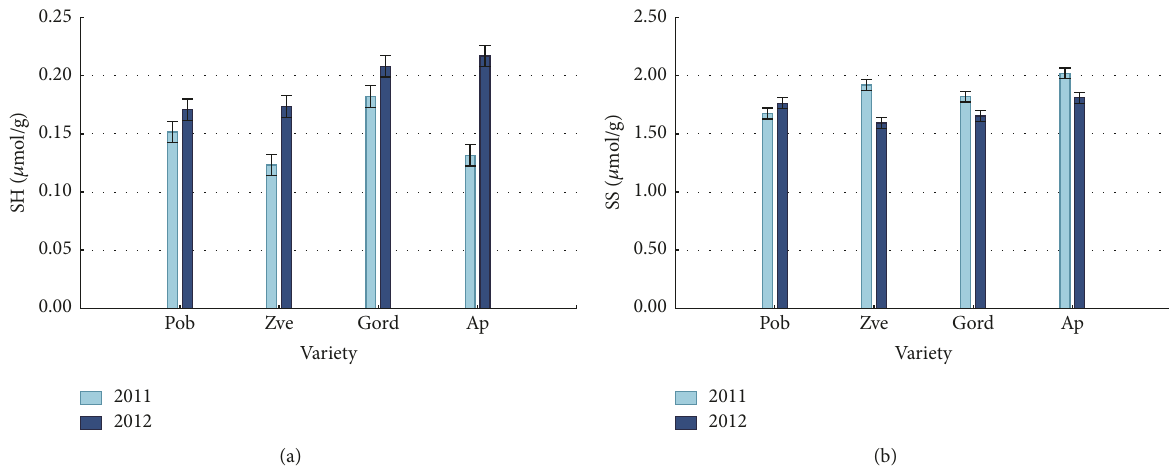
Figure 1: The influence of production year and variety on the content of free sulfhydryl groups (a) and disulphide bonds (b). Vertical bars denote 0.95 confidence